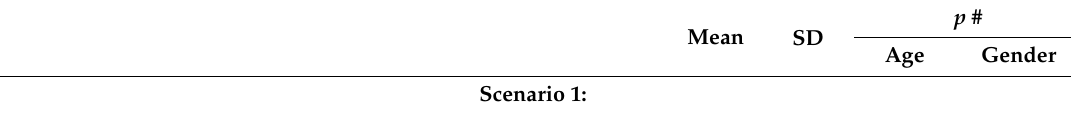
Table 3. Ratings of scenarios 1 and 2 ( n =